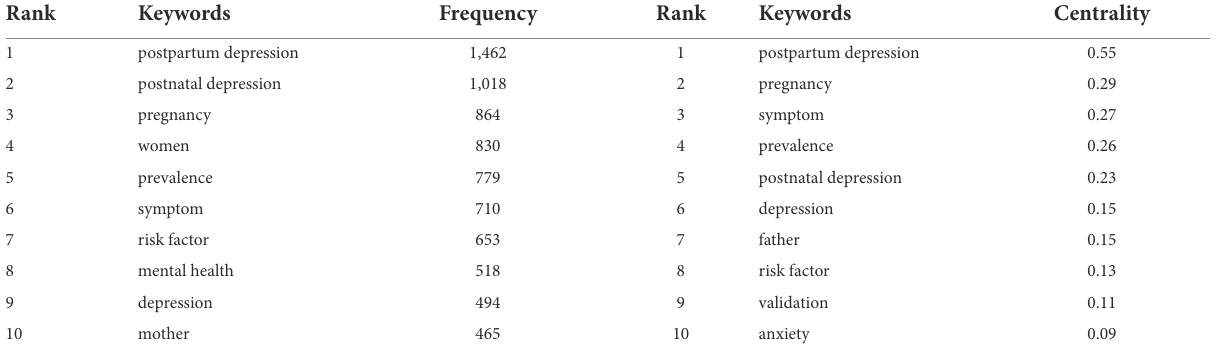
TABLE 7 TOP 10 Keywords in terms of frequency and centrality in the field of